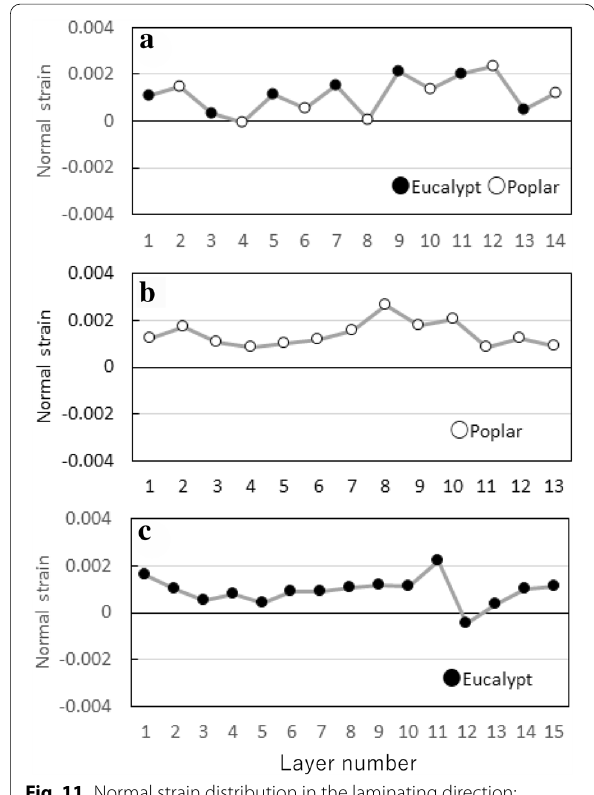
Fig. 11 Normal strain distribution in the laminating direction: horizontal axis: layer number, a PE-LVL, b P-LVL, c E-LVL. Figure a is a different specimen from Fig. 10